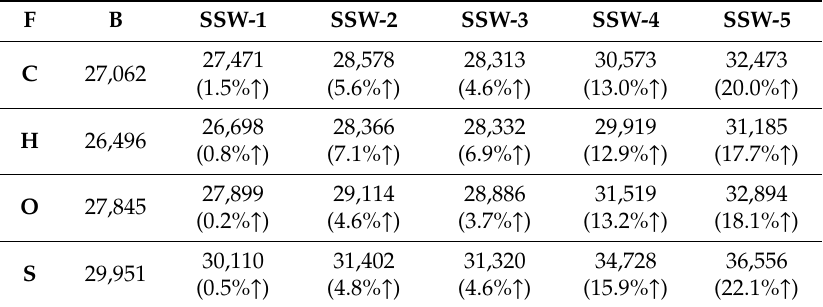
Table A3. Travel distance from residents in Our Lady Fatima Parish to destinations.